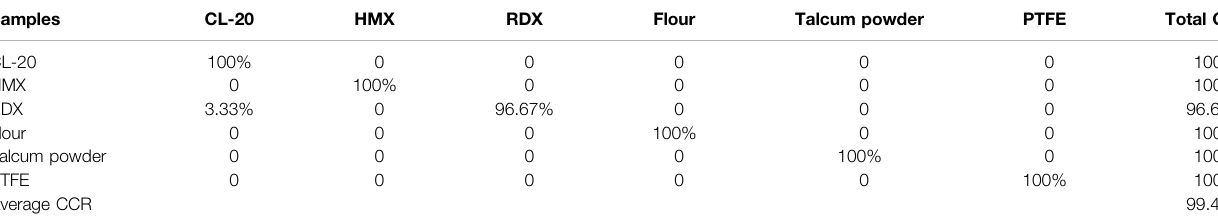
TABLE 4 | Correct classi fi cation rate of SVM2 model using thirteen lines. Samples